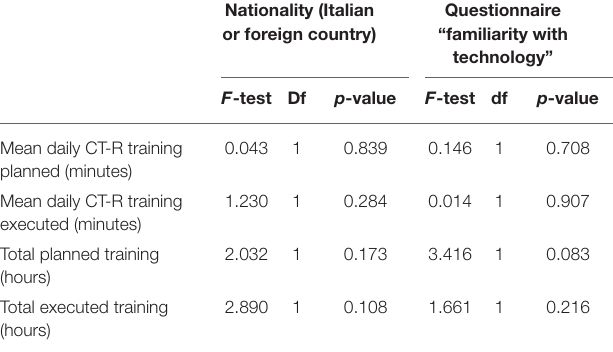
TABLE 3 | Mothers